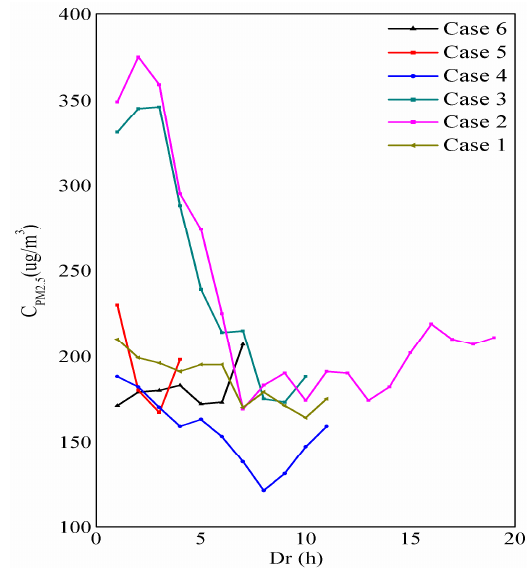
Figure 3. The temporal variations of C PM2.5 for the six cases.